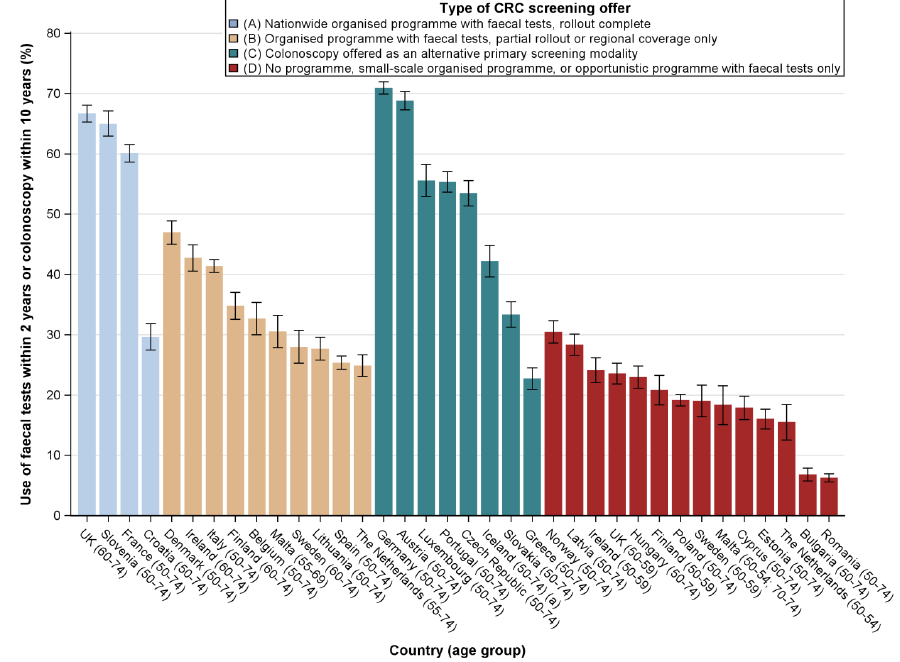
Figure 3. Prevalence estimates of faecal test use within the previous 2 years or colonoscopy use